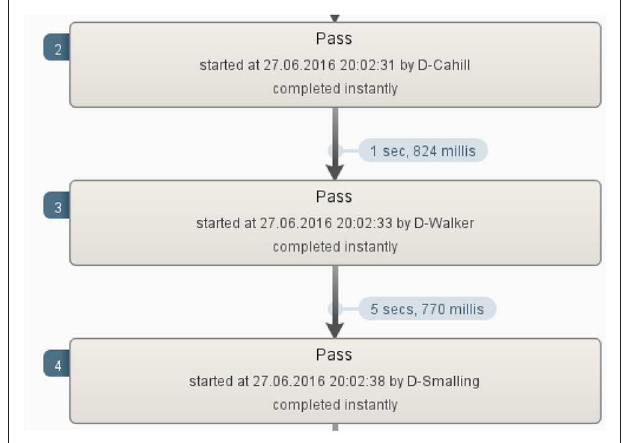
FIGURE 3 | Closer inspection of a sequence ending in the event “miss”.